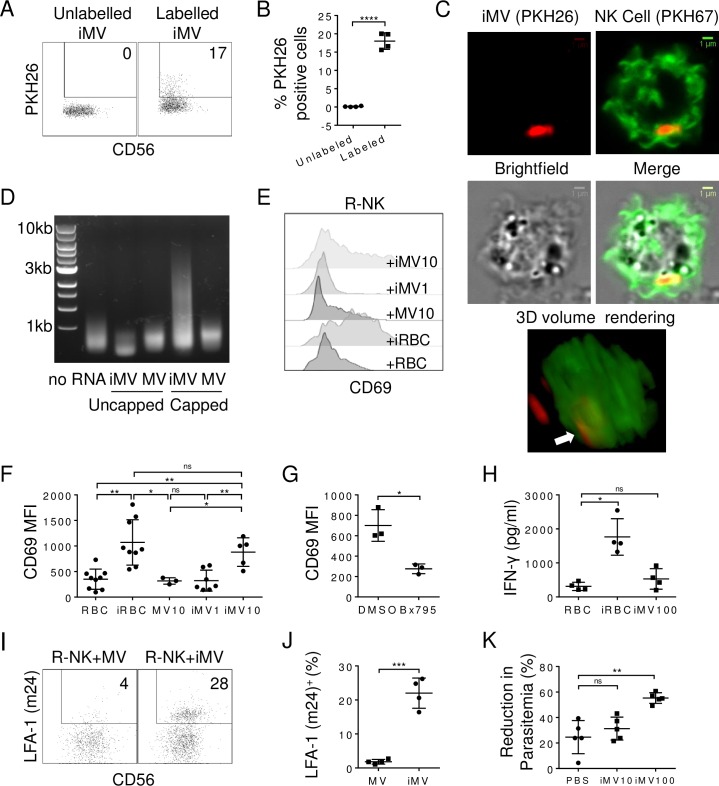
Microvesicles derived from iRBCs prime NK cells.(A-B) iMVs (1 μg/ml) were either labeled or not labeled with PKH26 and then cultured with R-NK cells for 24 h. Shown are representative PKH26 vs CD56 staining profiles. Numbers indicate the percentage of positive cells in the gated region (A). Comparison of percentages of PKH26-positive NK cells in cultures with unlabeled or labeled iMV (B). (C) Confocal microscopy of PKH67-labelled R-NK cells after 24 h incubation with PKH26-labeled iMVs. Shows are representative images of an NK cell with an internalized iMV. Z-stack of 1 μm slices were captured and 3D volume rendering was performed to demonstrate the location of the internalized iMV (white arrow). (D) Gel electrophoresis of cDNA derived from capped and uncapped RNAs of MVs and iMVs. Size markers are labeled on the left. No RNA: no RNA was added during the reverse transcription. (E-F) Representative CD69 histograms of R-NK cells cultured with RBC (NK+RBC), iRBCs (NK+iRBCs), MVs at 10 μg/ml (NK+MV10), iMVs at 1 (NK+iMV1) and 10 μg/ml (NK+iMV10) (E) and comparison of CD69 MFI on R-NK cells from different donors in the indicated culture conditions (F). (G) Comparison of CD69 MFI on R-NK cells cultured with iMVs (at 10 μg/ml) in the presence of DMSO (control) or Bx795 (10 nM). (H) IFN-γ levels in the culture supernatants of R-NK cells cultured with RBCs, iRBCs, and iMVs at 100 μg/ml for 48 h. (I-J) R-NK cells were cultured in the presence of MVs or iMVs at 10 μg/ml for 96 h, and LFA-1 activation was assessed using m24 antibody. Shown are representative LFA-1 (m24) vs CD56 staining profiles of NK cells (I), and comparison of percentages of LFA-1 (m24)-positive NK cells (J) in the indicated conditions. (K) Comparison of parasitemia reduction when NR-NK cells were co-cultured with iRBCs without iMVs, with 10 μg/ml iMVs (iMV10) or 100 μg/ml iMVs (iMV100) for 96 h. Each symbol represents a different individual. Error bars represent mean ± SD. *p<0.05, **p<0.01, ***p<0.001, ****p<0.0001, ns: not significant.